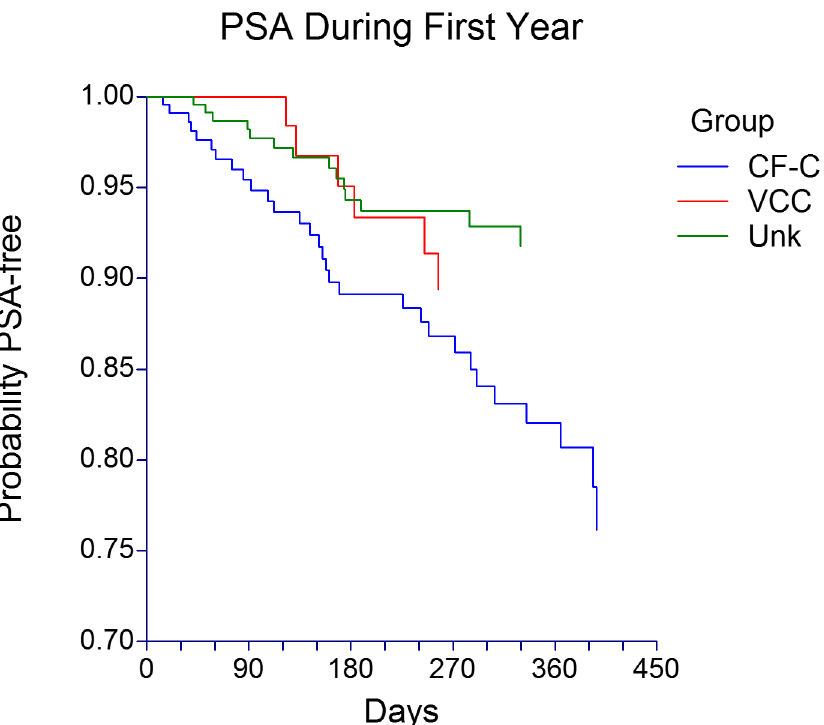
Fig 3. Pseudomonas aeruginosa first acquisition in the first 12 months of life. PSA = Pseudomonas aeruginosa , CF-C = CF-causing group (n = 231), VCC = mutation of varying clinical consequence group (n = 78), Unk = mutation of unknown liability group (n = 243). The probability of acquiring PSA was different among the 3 groups (p = 0.0088 Log-Rank test). CF-C group had a probability of acquisition rate of 0.18 (s.e. 0.03), which was not statistically significantly different than the VCC group (0.11 s.e. 0.04, p = 0.0916), but statistically higher than the Unk group (0.08 s.e. 0.02, p = 0.0034) according to pairwise comparisons.